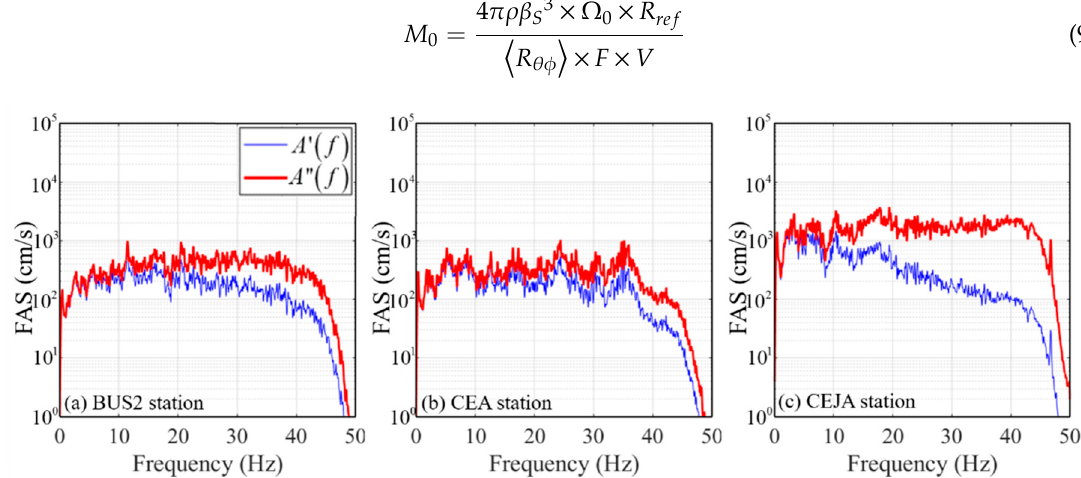
Figure 7. 𝐴 (cid:4593) (cid:4666)𝑓(cid:4667) versus 𝐴 (cid:4593)(cid:4593) (cid:4666)𝑓(cid:4667) for three sample stations: (a) BUS2 station, (b) CEA station, Figure 7. A (cid:48) ( f ) versus A (cid:48)(cid:48) ( f ) for three sample stations: ( a ) BUS2 station, ( b ) CEA station, (c) CEJA station. ( c ) CEJA station.